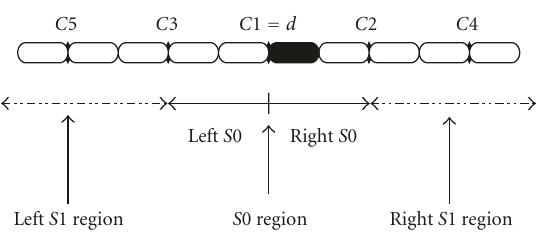
Figure 2: The 5 microcells